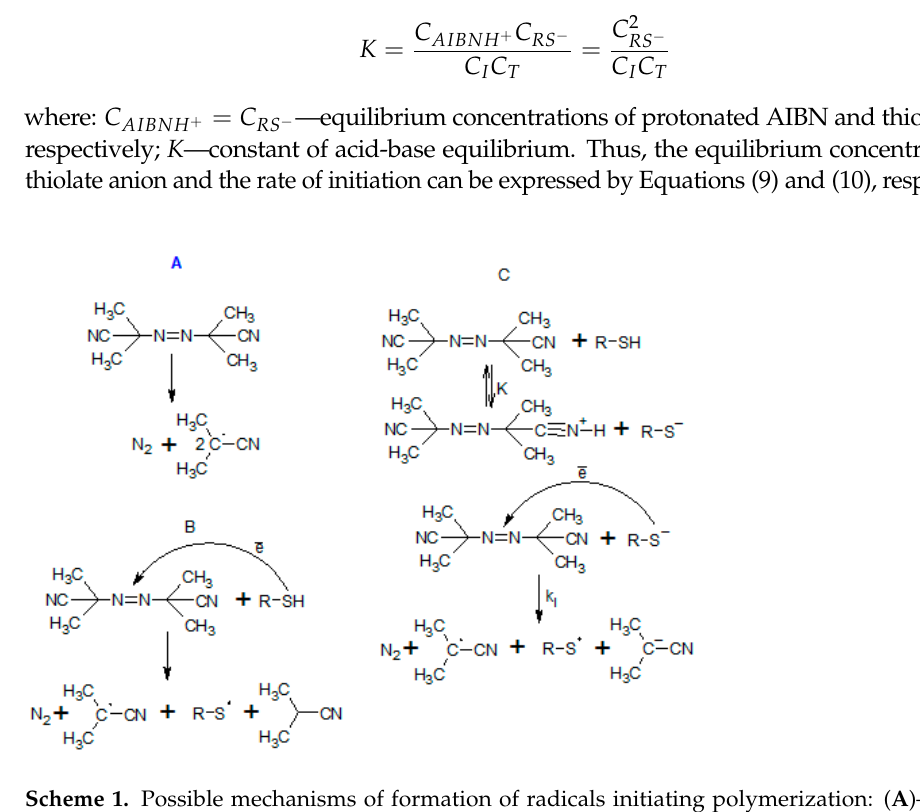
Scheme 1. Possible mechanisms of formation of radicals initiating polymerization: ( A )—due to thermolysis of AIBN; ( B )—due to the redox reaction of AIBN and mercapto acids; ( C )—due to the redox reaction of AIBN and thiolate anions of mercapto acids (dianions of mercapto acids). Assuming that there is bimolecular chain termination, we can write the kinetic Equa-